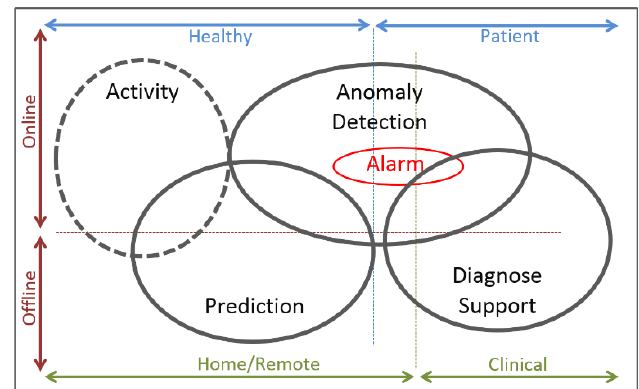
Figure 1. Schematic overview of the four main data mining processes (activity, prediction, anomaly detection and diagnose/decision support) in relation to different aspects of wearable sensing in wearable health devices. Filled line- Medical purposes; Traced line: Activity purposes. Adapted from [11].